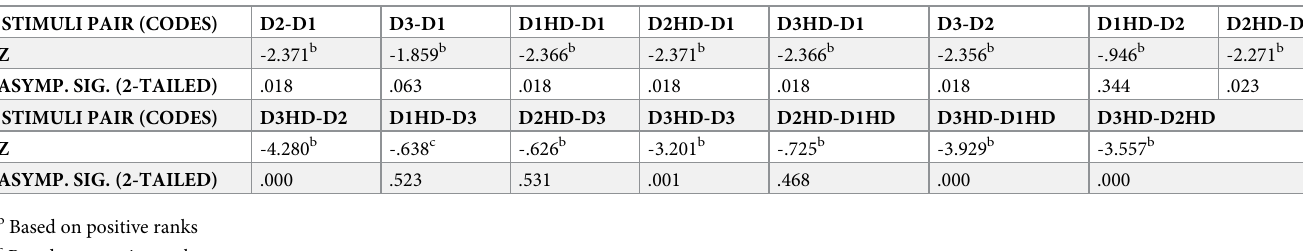
Table 8. Wilcoxon signed ranks test—task 3.